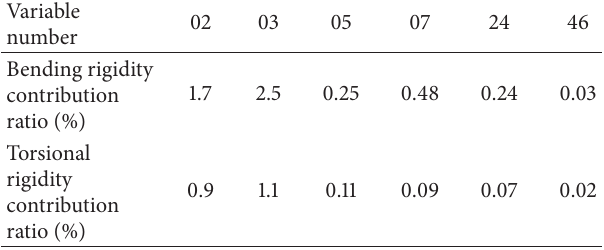
Table 6: Weight loss comparison of main parts in battery pack.